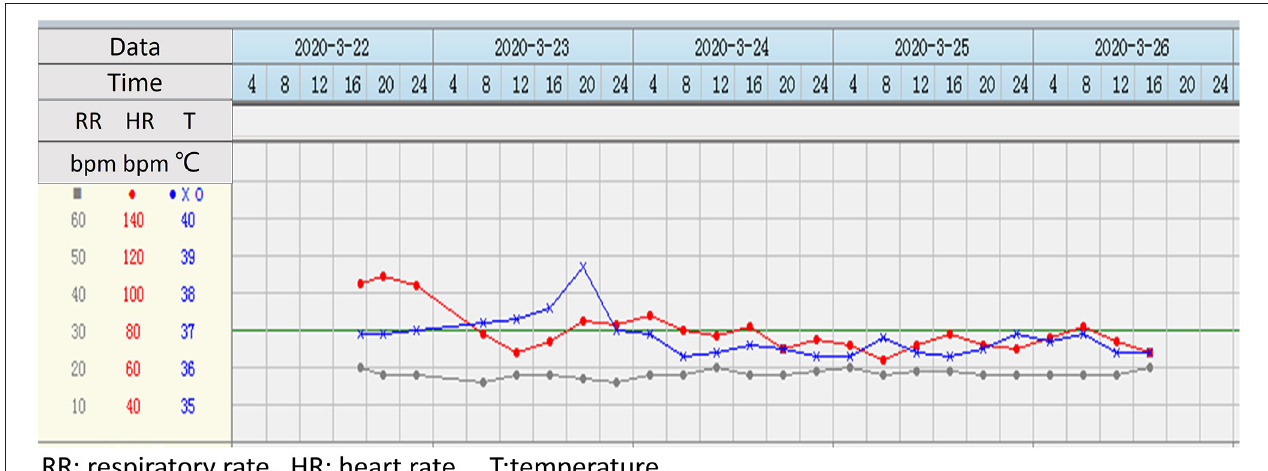
FIGURE 2 | Real-time monitoring of the patient’s vital signs during hospitalization.